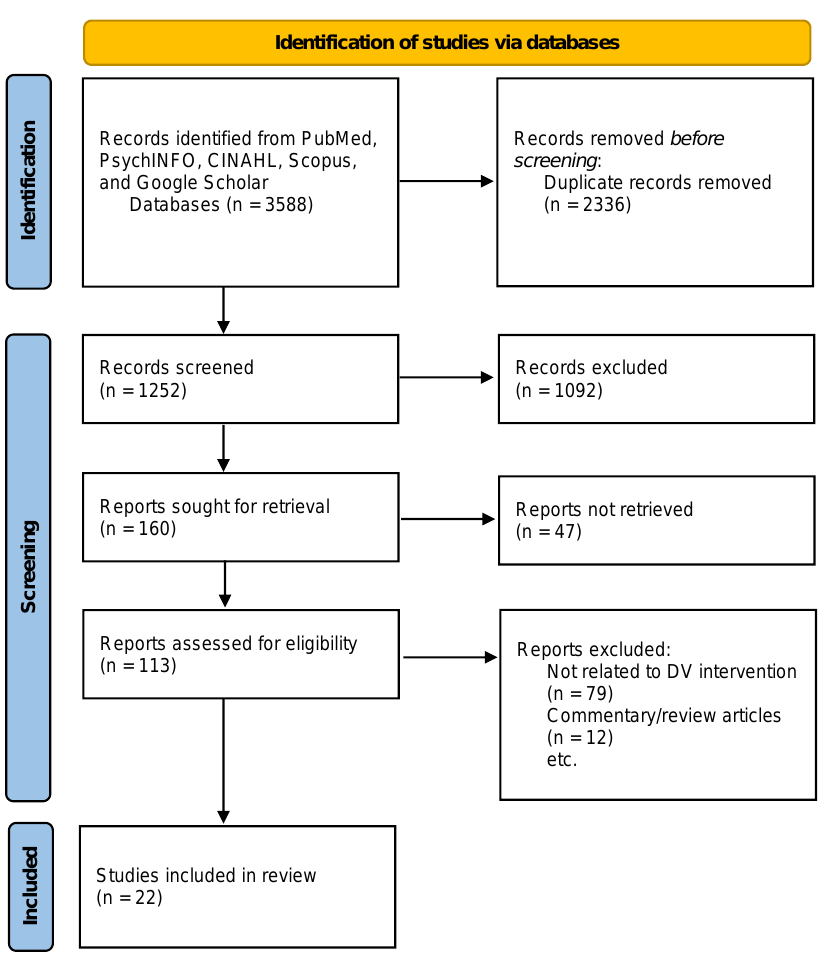
Figure 1. PRISMA Flow chart—integrative review of machine learning in domestic violence.